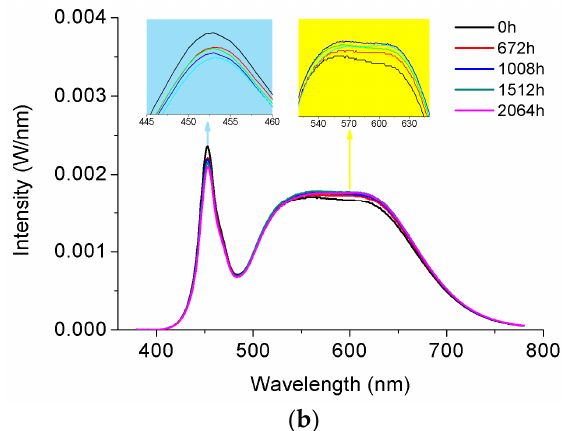
Figure 9. Attenuation of spectral power distributions of the 4000 °K samples during SSADT. ( a ) Driving by a 120 mA current; ( b ) Driving by a 350 mA current.